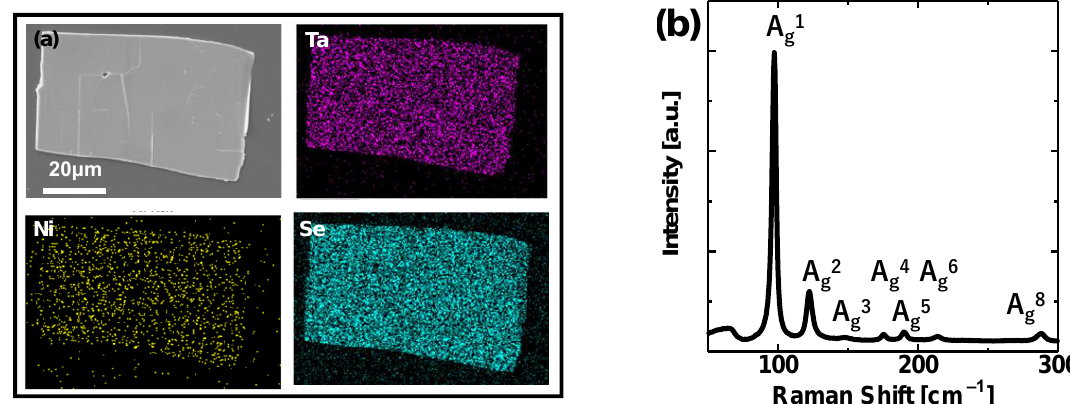
Figure 2. ( a ) SEM image of the Ta 2 NiSe 5 film with elemental analysis of EDX; ( b ) Raman spectrum of the Ta 2 NiSe 5 film.